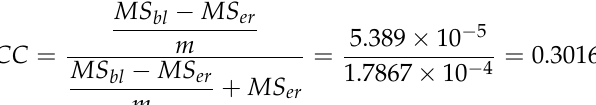
Batteries 2022 , 8 , x FOR PEER REVIEW